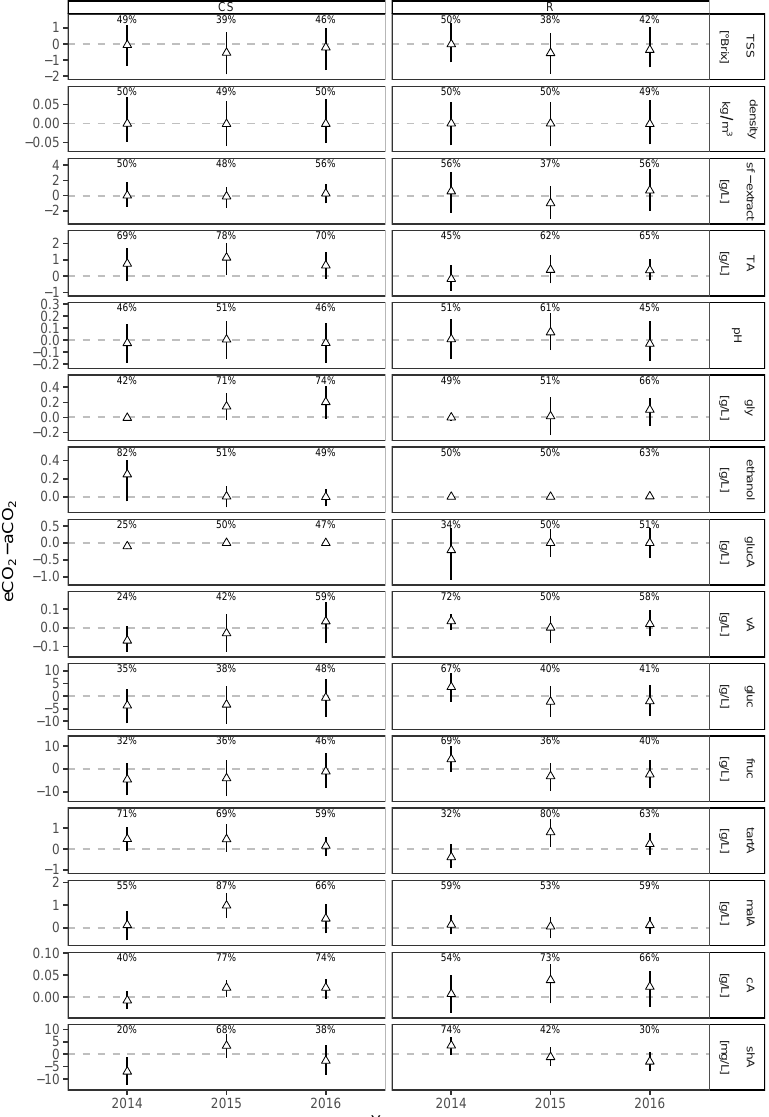
Figure 2. Posterior predicted difference (median and 50% HDI) between eCO 2 and aCO 2 for each measurement year from Bayesian generalized linear mixed effects models on analyzed must parame- ters of Cabernet Sauvignon (CS) and Riesling (R). Percentages represent the probability of eCO 2 -aCO 2 > 0. Filled symbols indicate “significant differences”, if the probability is >90% (positive difference) or <10% (negative